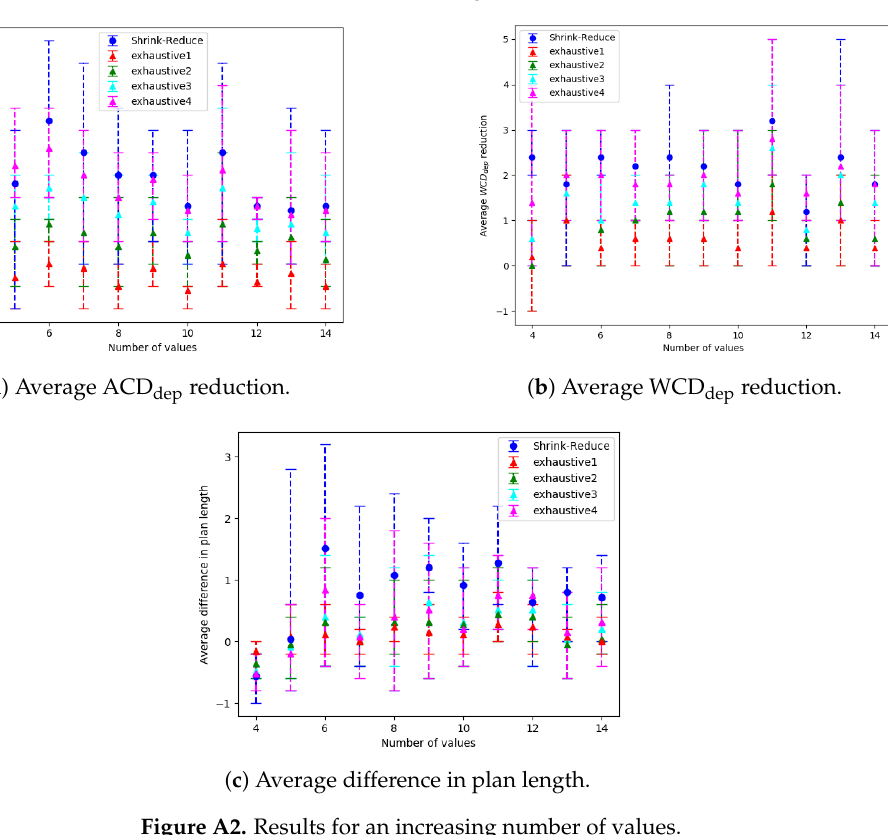
Figure A1. Results for an increasing number of variables.